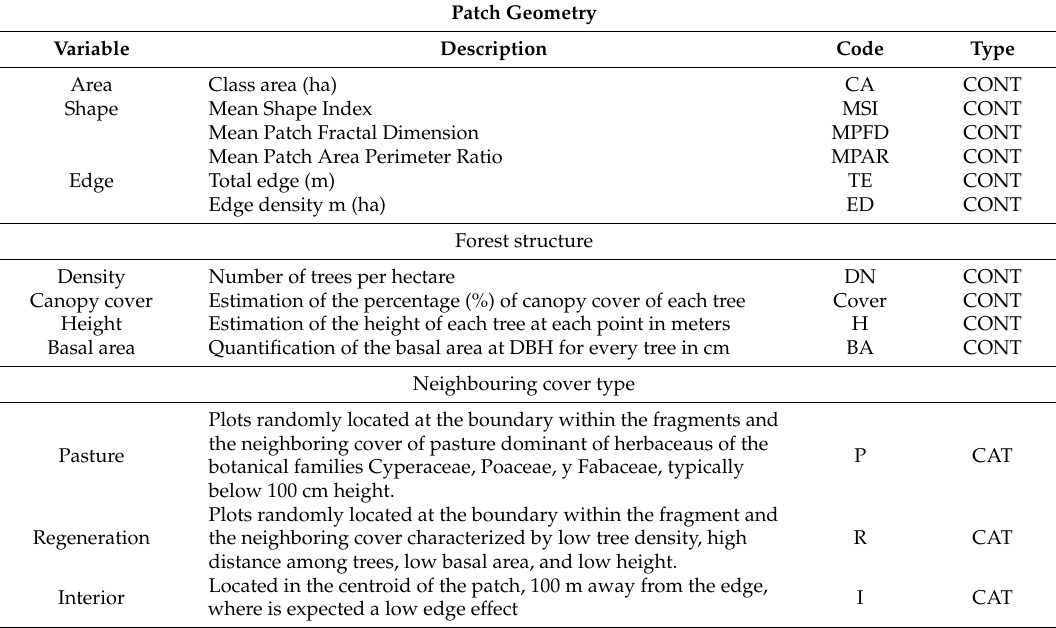
Table 2. Summary of the explanatory variables measured. Variables were classified broadly as those of patch geometry, forest structure, and neighboring cover type; variables are either continuous (CONT) or categorical